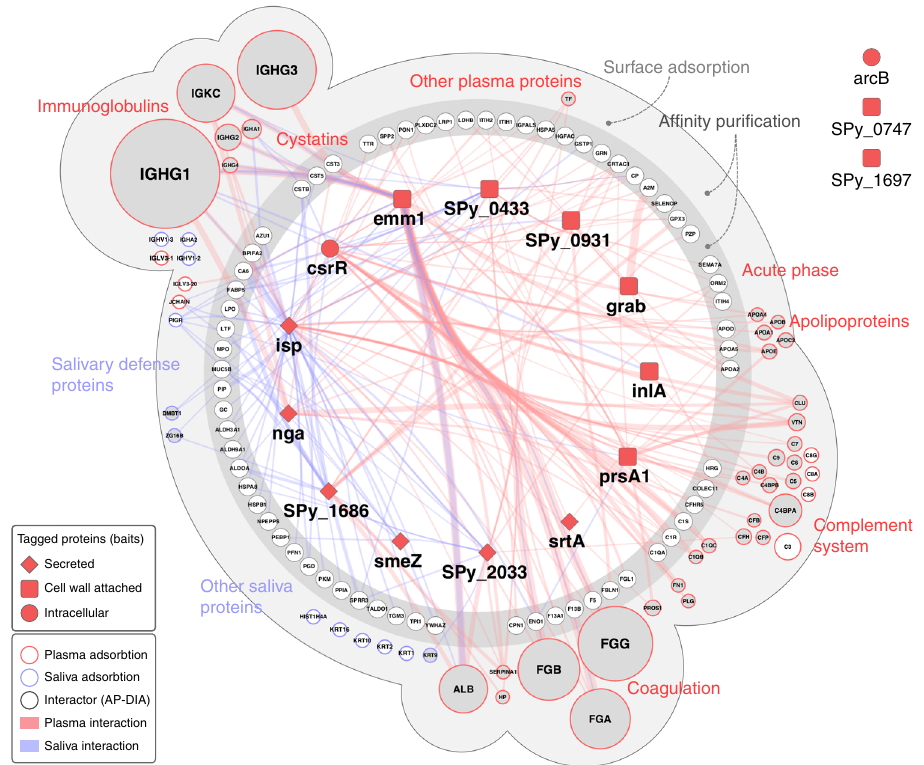
Fig. 2 A combined network layout of the AP – DIA and SA – DIA interaction maps. Overlap of the AP – DIA and SA – DIA plasma and saliva interactomes. Streptococcal bait proteins are presented as dark red squares (cell wall-attached proteins), diamond shapes (secreted proteins) or spheres (intracellular proteins). The AP – DIA interactome is represented as the inner dark gray circle according to functional protein class, with the protein interactions indicated in red for human plasma and blue for saliva. The thickness of the edges connecting the nodes indicates the abundance of the captured human proteins in relation to the respective bait proteins. Proteins identi fi ed both in the AP – DIA and SA – DIA approaches are enclosed in the outer light gray sphere, where the circle sizes represent protein abundance derived from the SA – DIA experiments and the colors (red or blue) indicates predominant plasma or saliva protein interactions. The nodes of these overlapping interaction networks are fi lled in gray for easier visualization. Proteins exclusively identi fi ed in SA – DIA are placed in the outer light gray sphere and are not connected with edges. Streptococcal bait proteins without any identi fi ed human interactions are depicted outside the interactome area, being arcB, and the uncharacterized proteins Q9A0J7 ( Spy_0747 ) and Q99YH8 ( Spy_1697 ). The interactome views were generated using Cytoscape 69 and modi fi ed in Adobe Illustrator. Source data are provided as a Source Data fi